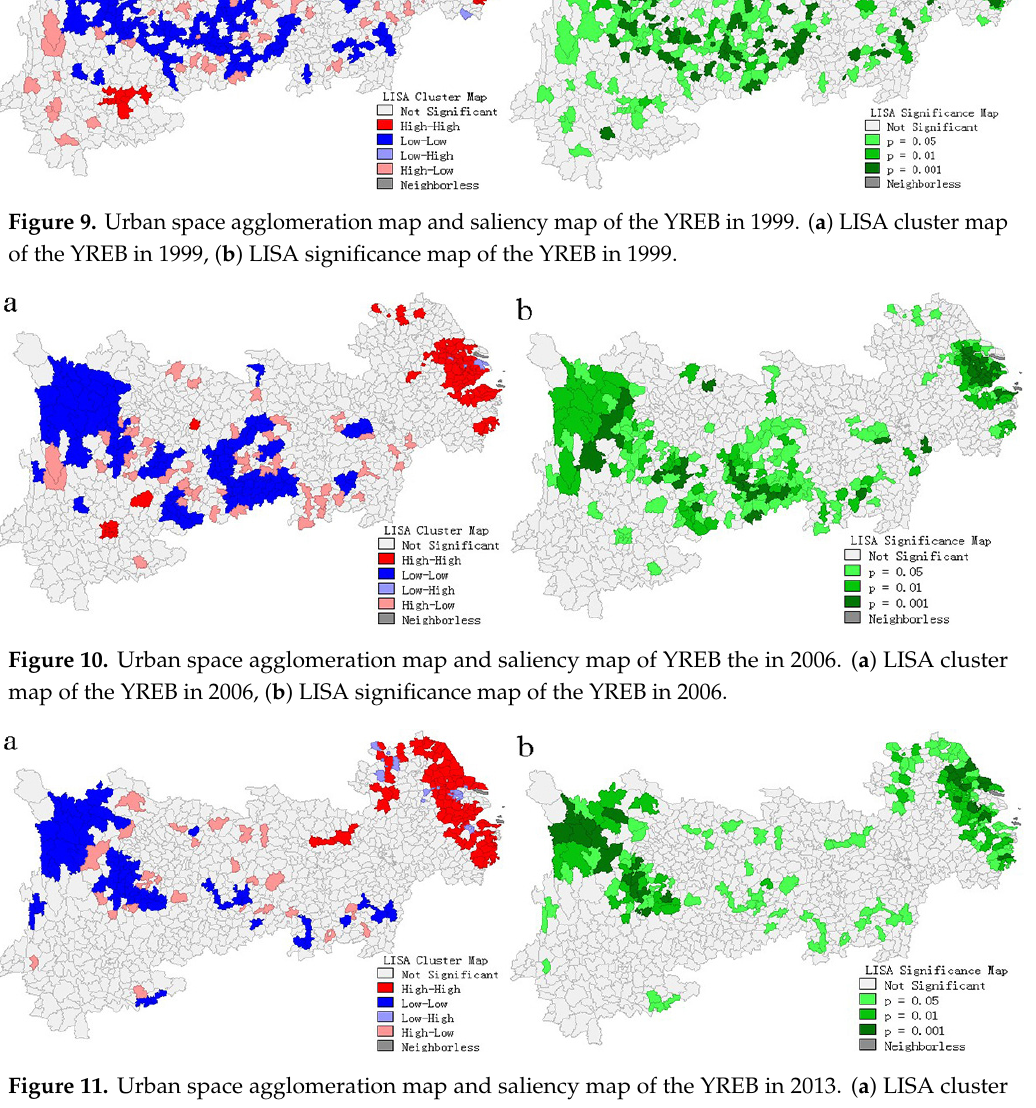
Figure 11. Urban space agglomeration map and saliency map of the YREB in 2013. ( a ) LISA cluster map of the YREB in 2013, ( b ) LISA significance map of the YREB in